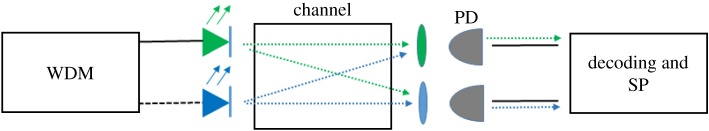
Typical MA-PHY model with two optical wavelengths. (Online version in colour.)